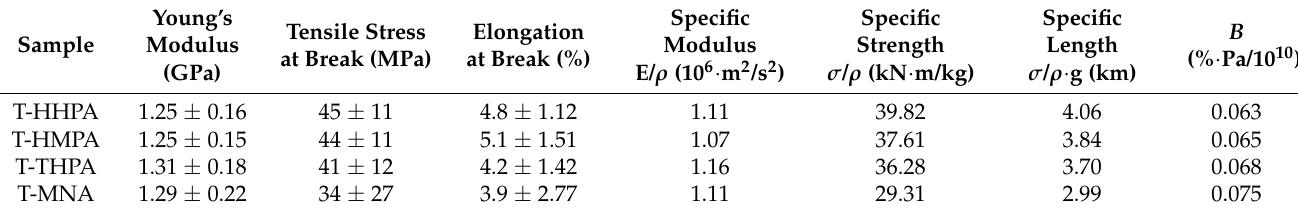
Table 4. Mechanical properties of the designed epoxy